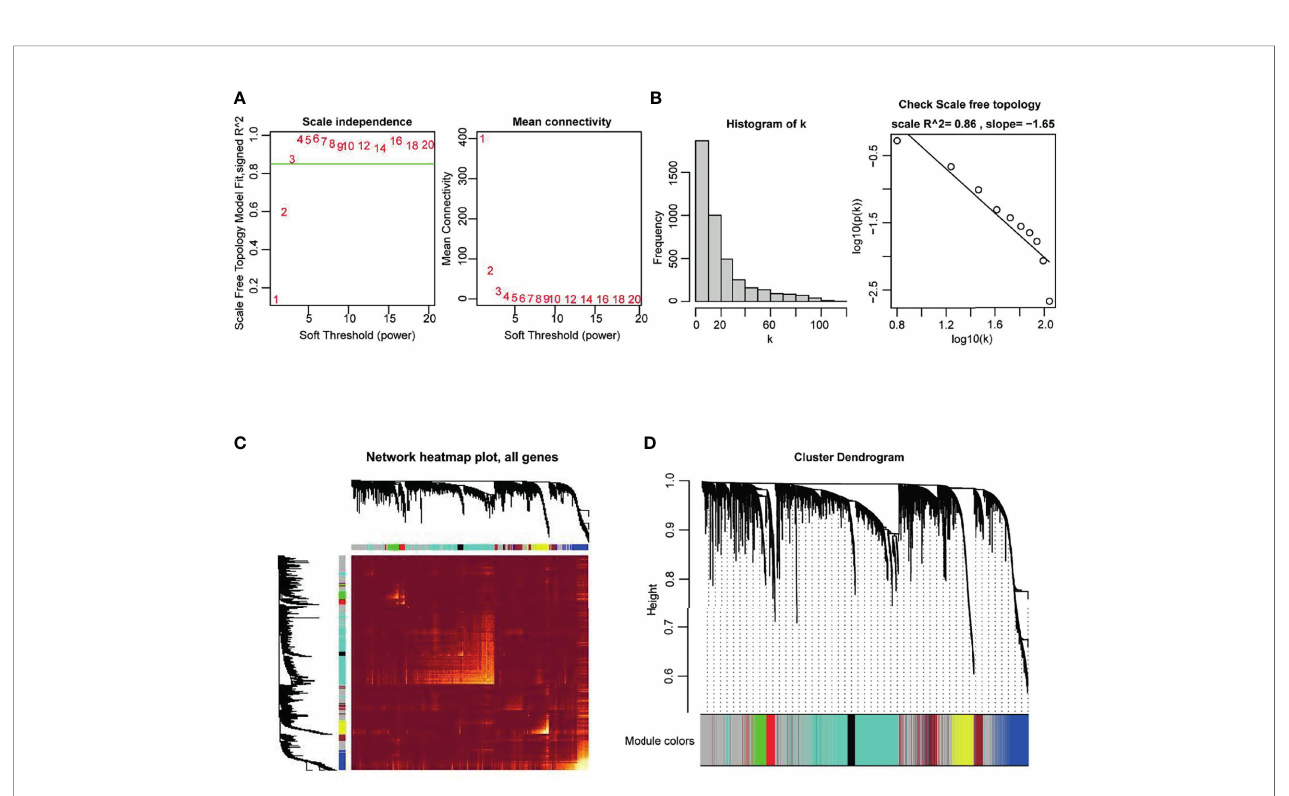
FIGURE 3 | Construction of weighted co-expression network of DEGs in UCEC. (A, B) Examination of the scale − free fi t index for distinct soft-thresholding powers ( b ), and average network connectivity under different weighting coef fi cients. b = 3 was selected as a soft threshold to construct the co-expression modules. (C) Heatmap depicting the TOM among DEGs based on the co-expression modules. (D) 8 modules were characterized due to a dissimilarity measure. Within the 8 modules, the grey module was a gene set in which the genes were not clustered into any